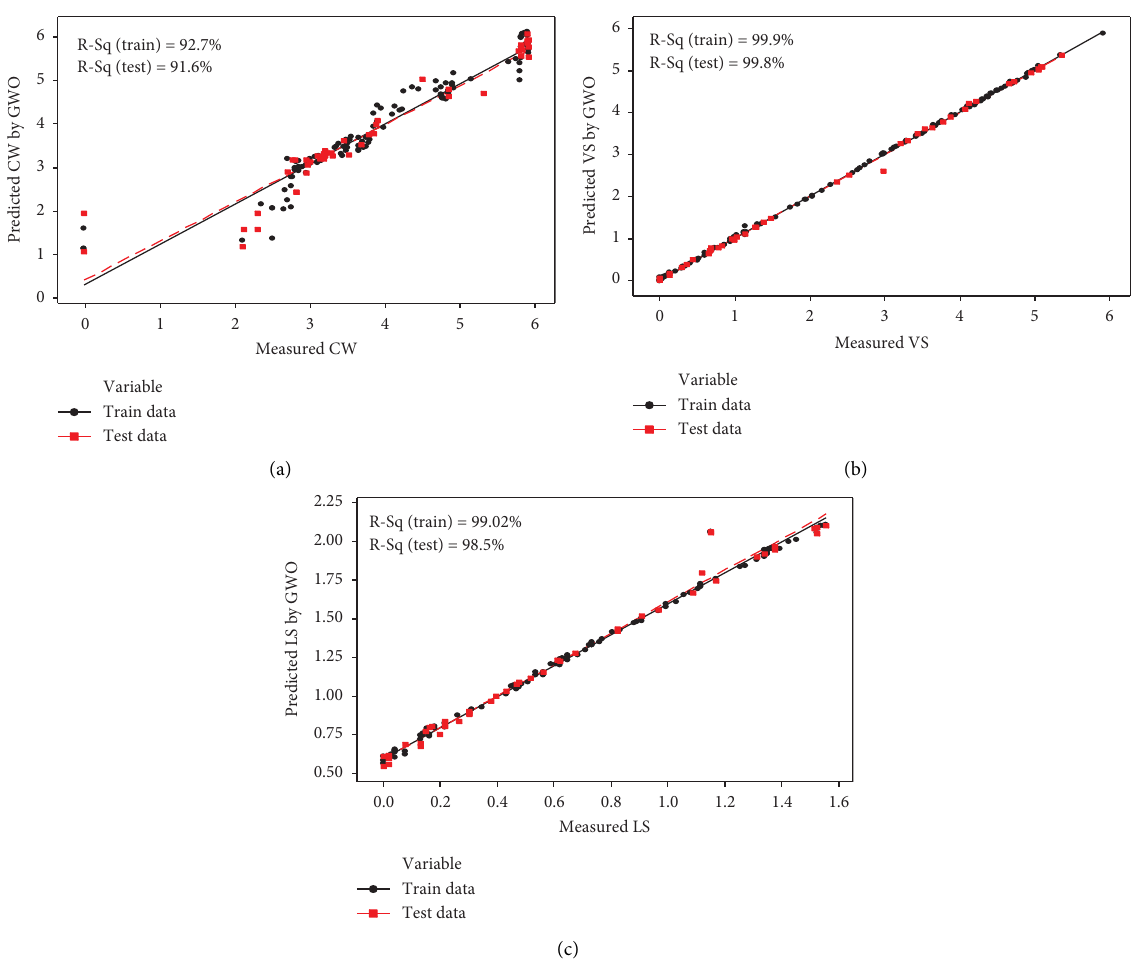
Figure 12: The values of R-squared for GWO models. (a) Crack width (CW), (b) volumetric shrinkage (VS), and (c) linear shrinkage (LS).